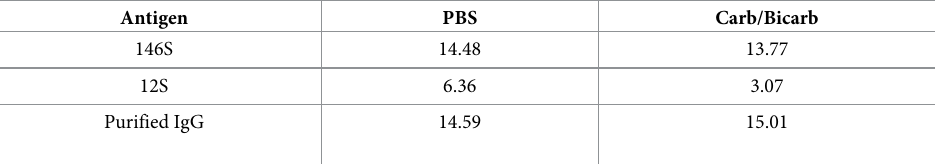
Table 2. Binding of 146S and 12S particles onto the ELISA plates. Excess amount of antigen was coated ON using either PBS or Carbonate/bicarbonate buffer. Plates were washed after the ON incubation at 4˚C and total coated pro- teins were quantified using a commercial